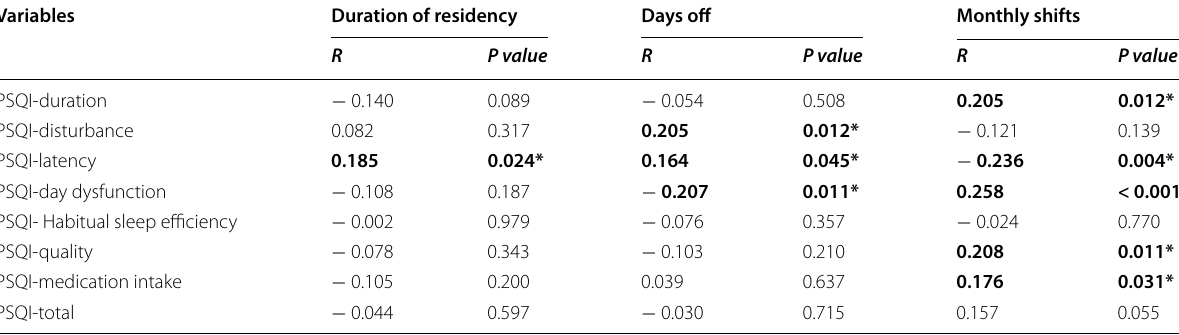
*indicates the presence of significance **indicates highly significance. R correlation coefficient